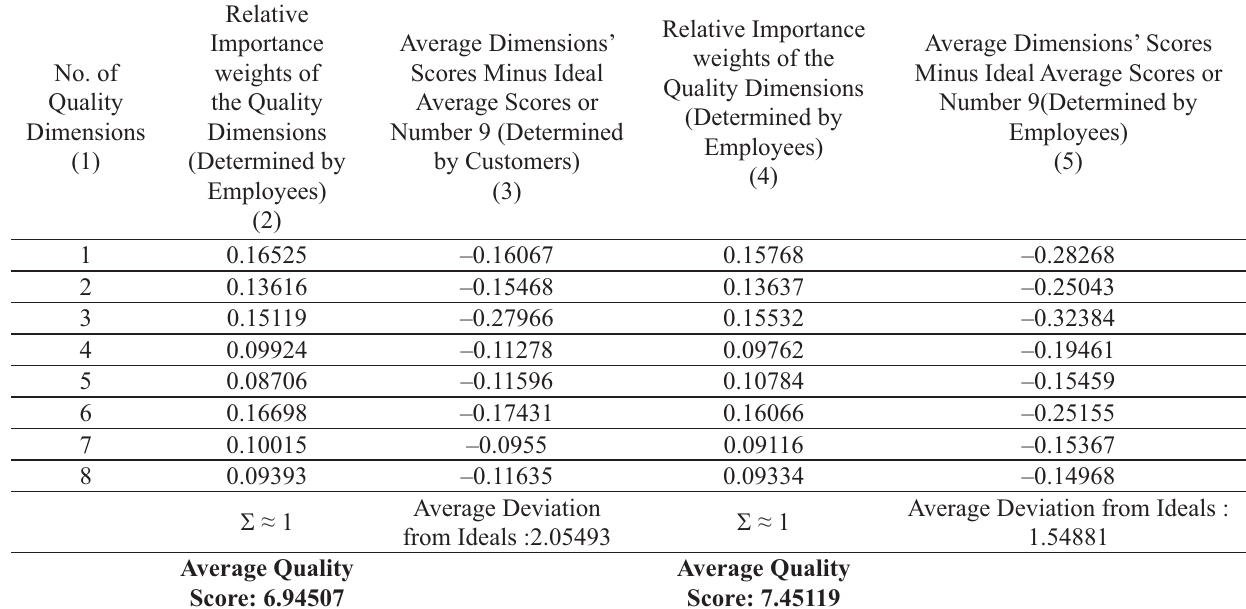
Table 3. Data for Weighted SERVQUAL Model